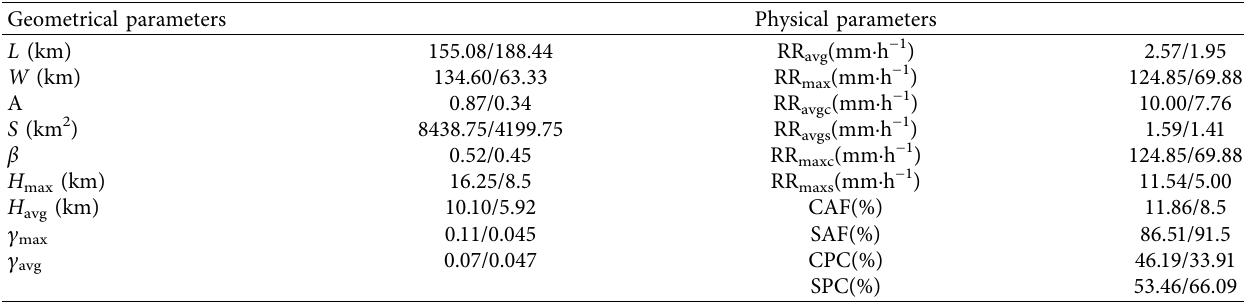
Table 3: The calculated (horizontal and vertical) and physical parameters of the first/second case. Geometrical parameters